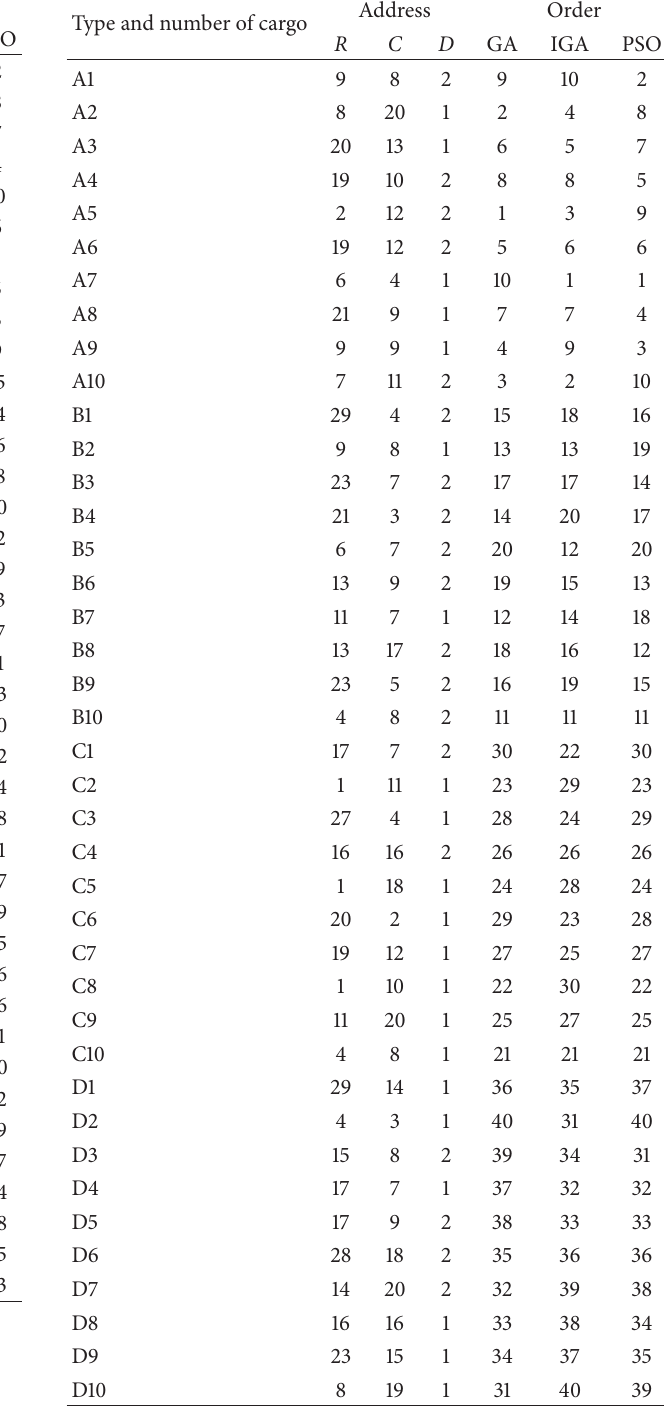
Table 1: The addresses of the stored cargo for simulation in Case 1. Type and number of cargo